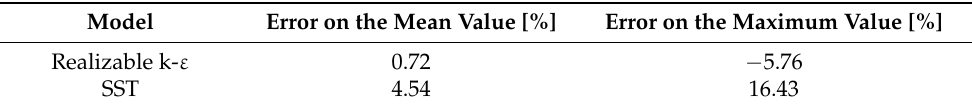
Table 1. Percentage errors with respect the experimental measurements for the single slot case with H/B = 8, Re = 1.1 × 10 4 .